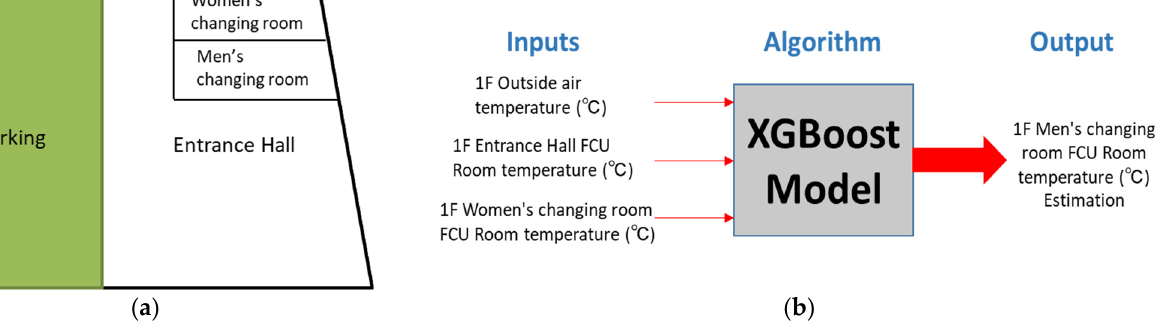
Figure 4. ( a ) 1st floor (1F) schematic; ( b ) estimation approach for 1st floor of the